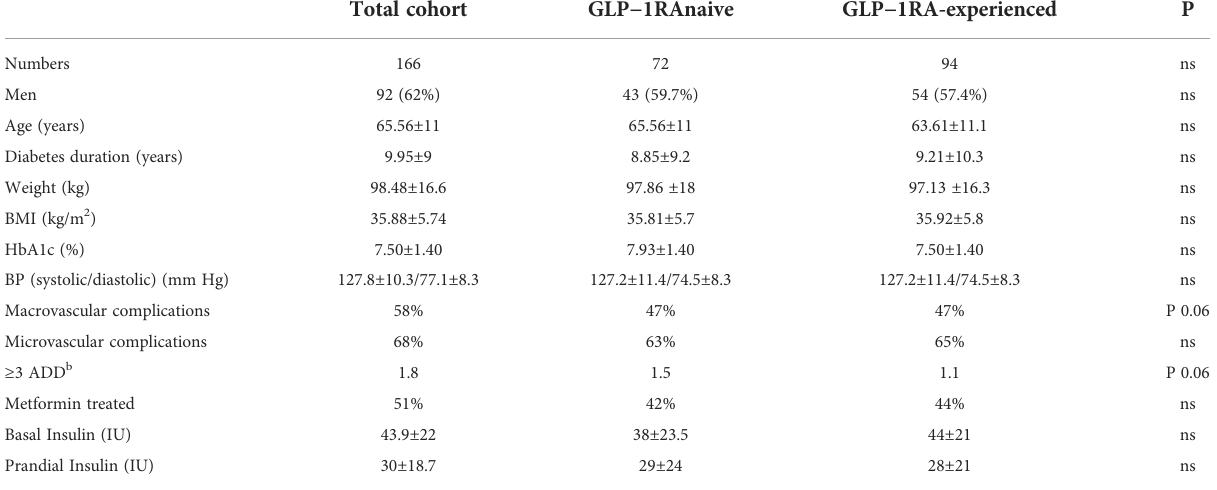
TABLE 1 Baseline characteristics of patients